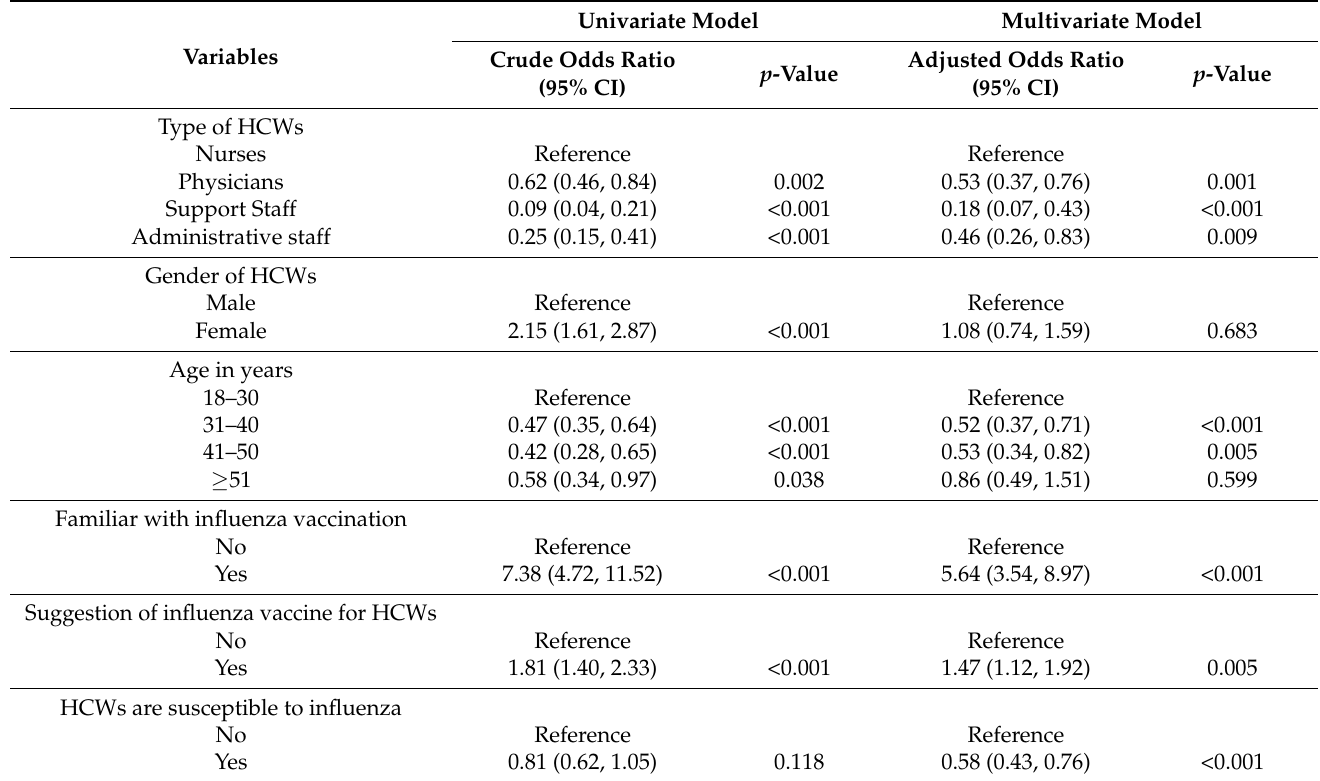
Table 3. Association between influenza vaccination uptake and multiple variables among vaccinated